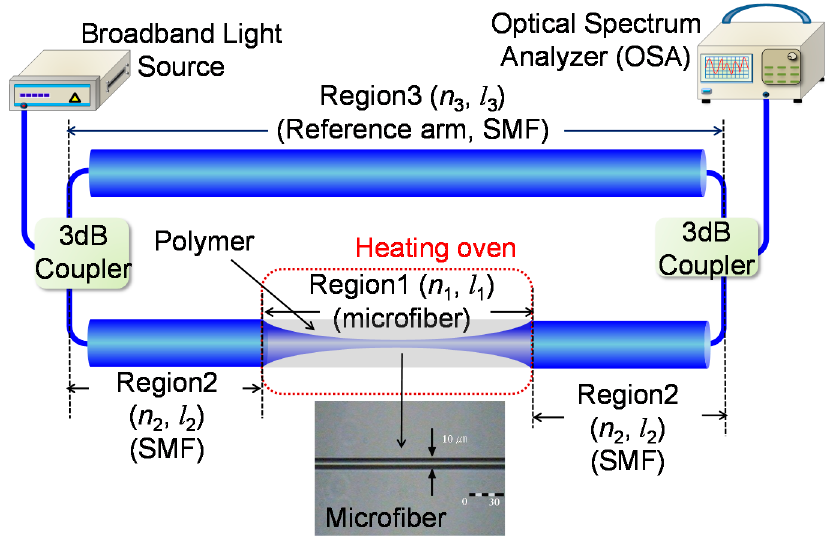
Figure 1. Experimental scheme for the polymer-overlaid microfiber MZI.